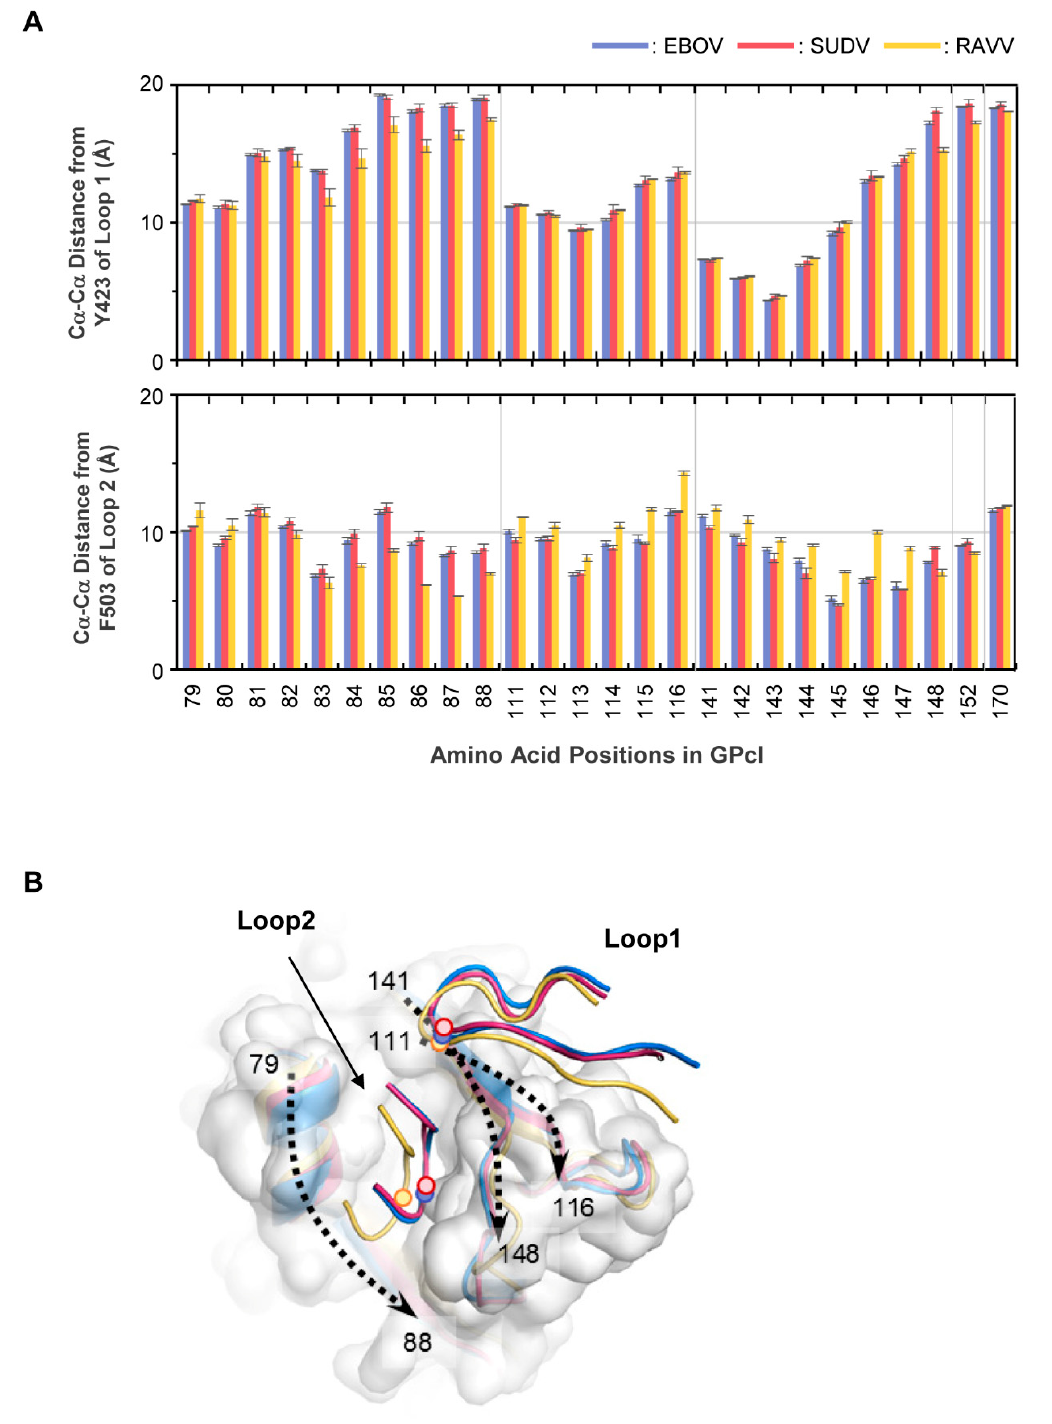
Figure 5. Differences in the GPcl–NPC1 binding structures between EBOV, SUDV, and RAVV. ( A ) Residue contact pairs of the GPcl–NPC1 interfaces for EBOV, SUDV, and RAVV were analyzed using the MOE software (version 2018; Chemical Computing Group, Montreal, Canada). Residue–residue contact pairs that appeared in at least 50% of the 1500 MD simulation frames, are shown for EBOV (blue), SUDV (red), and RAVV (yellow) GPcl–NPC1 complexes. In each panel, the light, intermediate dark, and darkest colors represent the contact pairs containing van der Waals interactions (vdW), vdW + hydrogen bonds (hb), and vdW + hb + salt bridges (sb), respectively. Amino acid residues that are distinct from those of EBOV GPcl are shown in red. The numbering scheme for GPcl was adapted from EBOV. ( B ) Venn diagram for the number of residue contact pairs observed for EBOV (blue), SUDV (red), and RAVV (yellow) GPcl–NPC1 complexes.